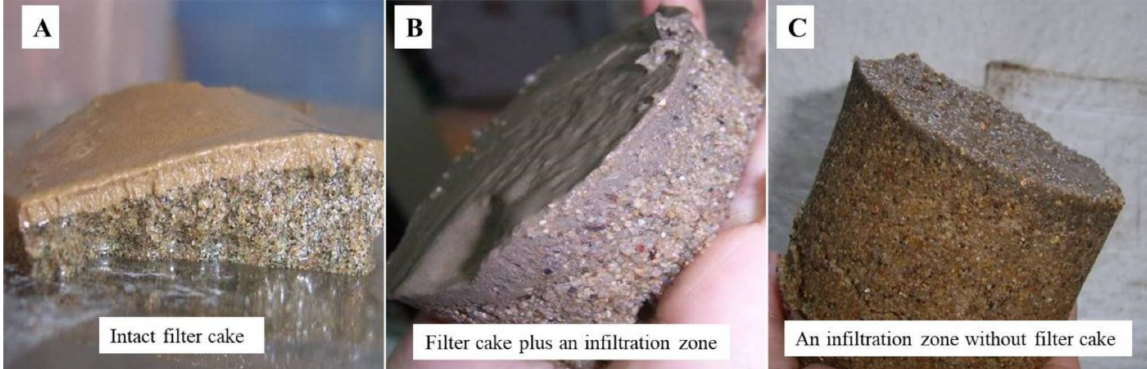
Figure 1. Three types of filter cake formation. ( A ) is an intact filter cake after the slurry particle accumulating; ( B ) is a filter cake plus permeation zone after the slurry particle accumulating; ( C ) is an infiltration zone without a filter cake after the slurry particle